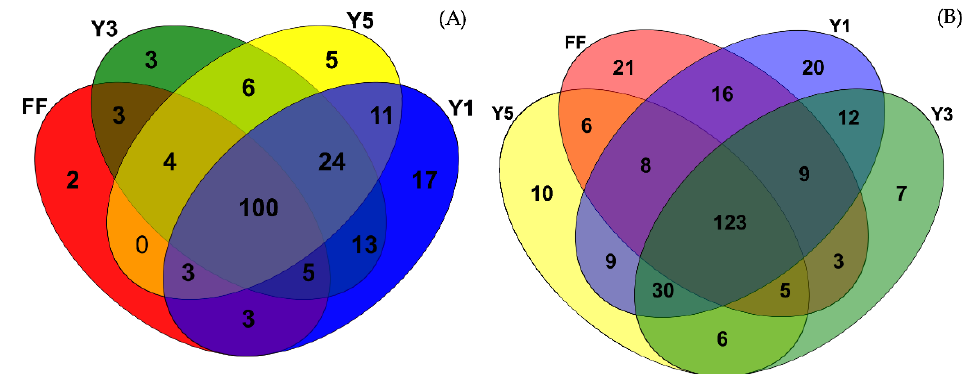
Figure 4. Venn diagrams showed shared and unique species of fungi in winter ( A ) and summer ( B